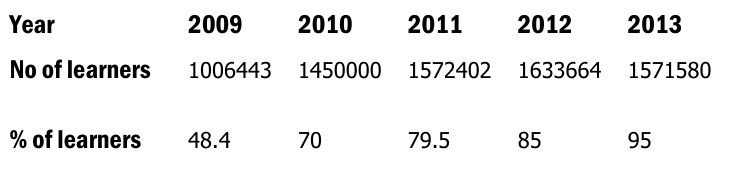
Table 6: % Learners benefiting from nutrition in the Eastern Cape from 2009-